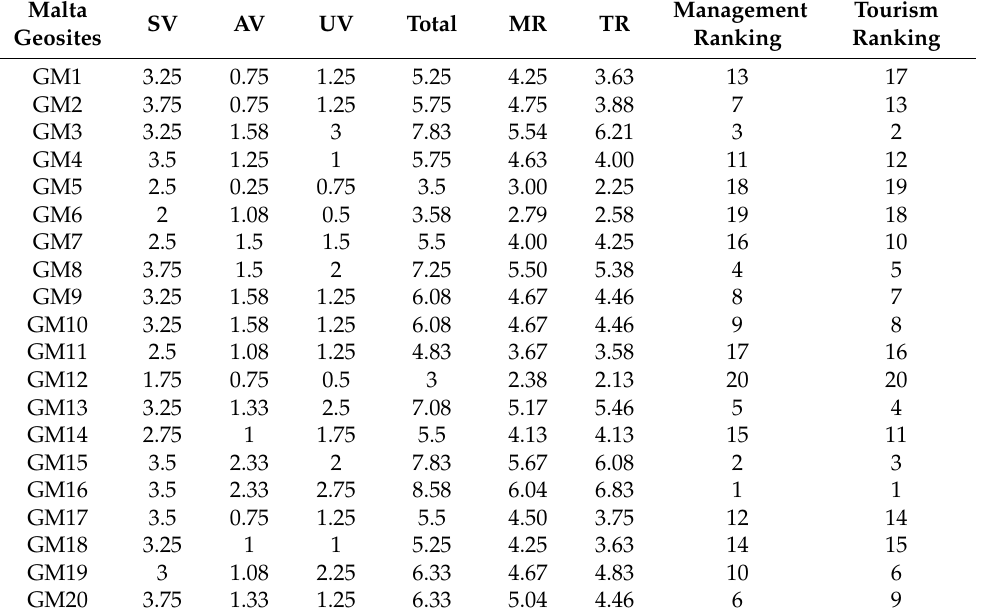
Table 2. General numerical assessment of the 20 sites of the Malta study area (GEOMAL). Legend: SV, scientific value; AV, additional value; UV, use value; MR, management rating; TR, tourism rating. Malta